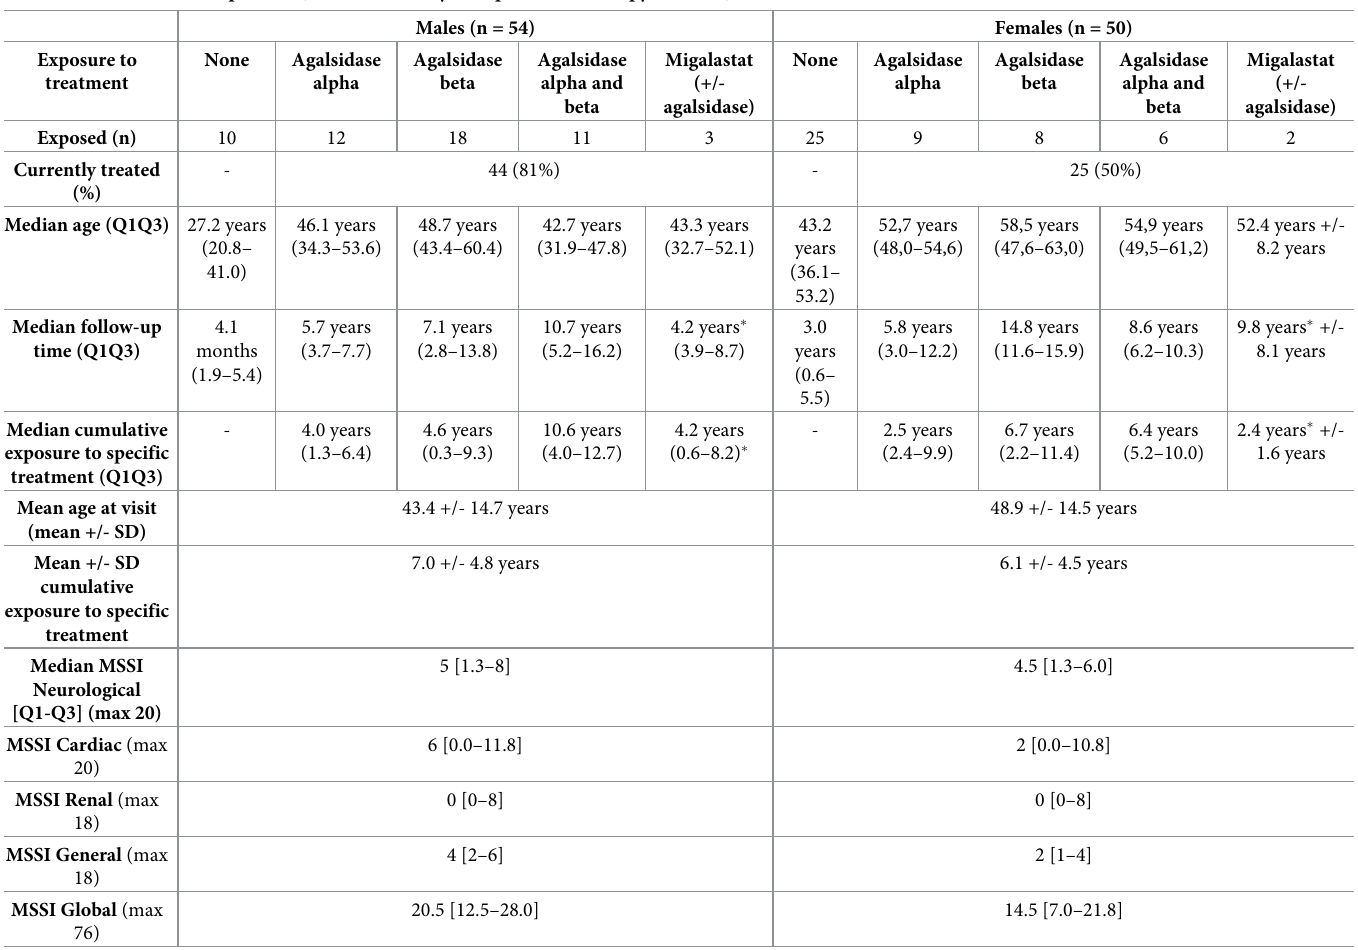
Table 1. Characteristics of patients ( � time under enzyme replacement therapy